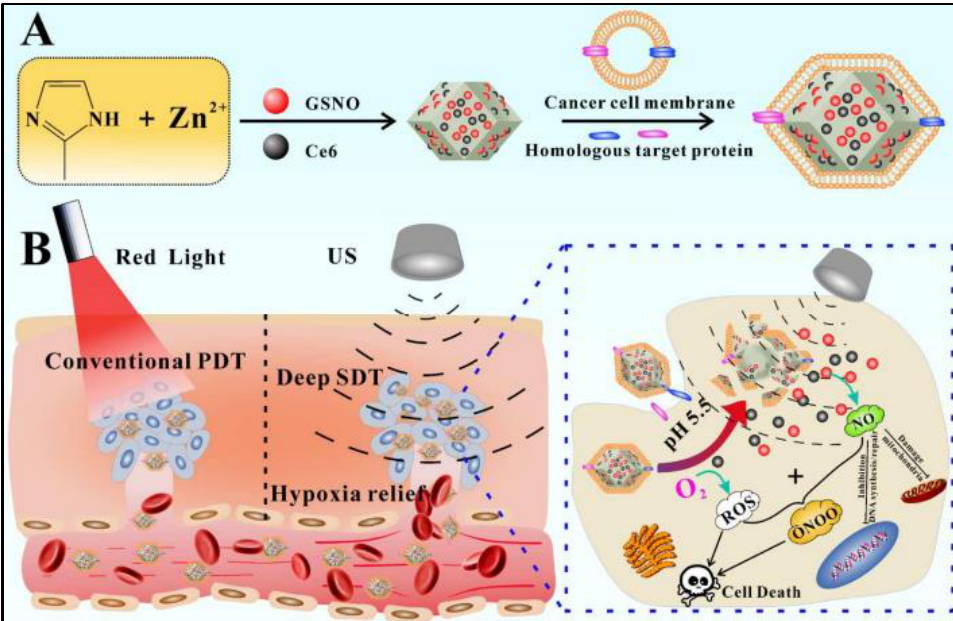
Figure 5. Scheme of the fabrication of the dual pH/ultrasound response biomimetic ZIF-8@Cy- tomembrane nanoplatform and gas-sonodynamic combined therapy. ( A ): The encapsulation strat- egy the formulation; ( B ): The release mechanism of the formulation